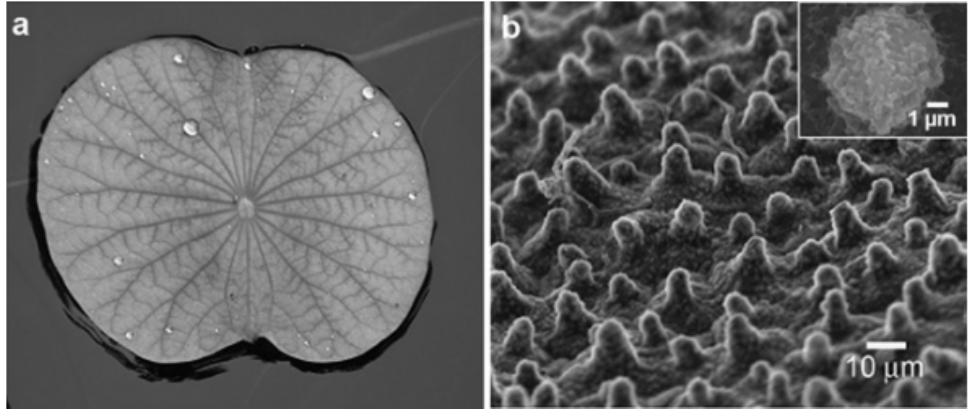
Figure 6. ( a ) A photograph of a lotus leaf floating on the water surface. ( b ) A SEM view of the lotus surface. The papilla structure is enhanced in the inset. Reprinted from [86]. Copyright 2005, with permission of RSC.